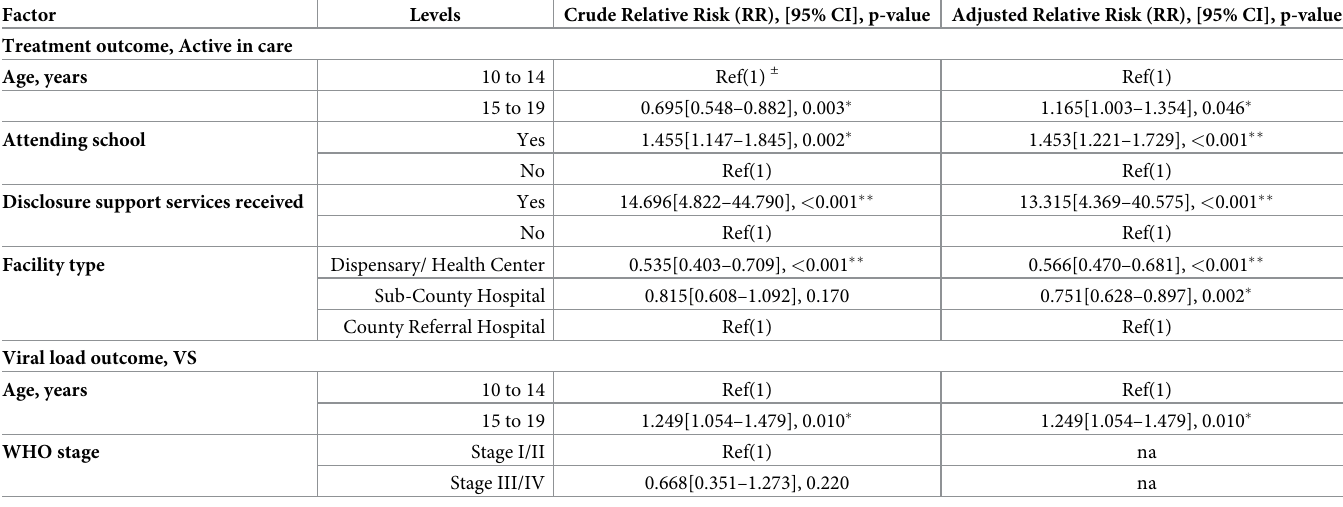
Table 3. Relative risk of treatment (active in care) and VS outcomes in relation to associated factors of ALHIV enrolled in HIV between July 2017 and June 2018 in select HCFs in Homabay and Kakamega